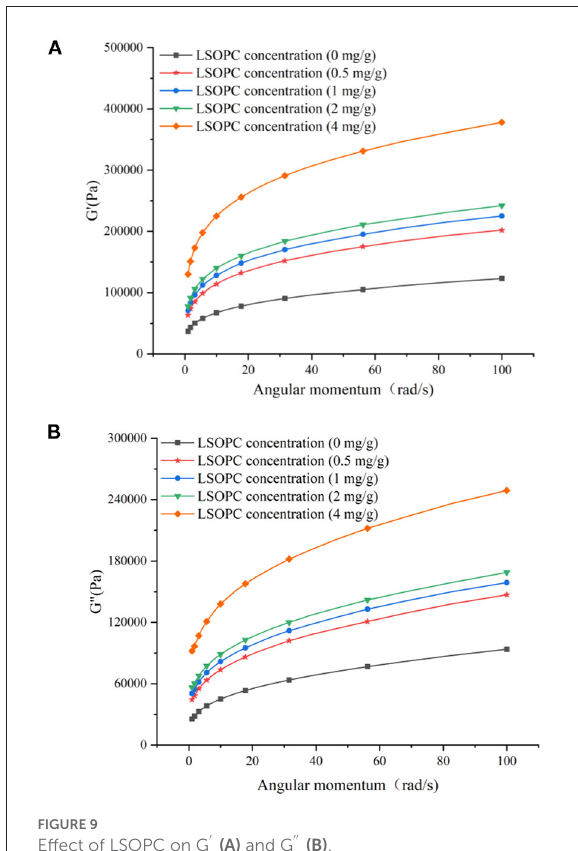
FIGURE9 Effect of LSOPC on G ′ (A) and G ′′ (B)